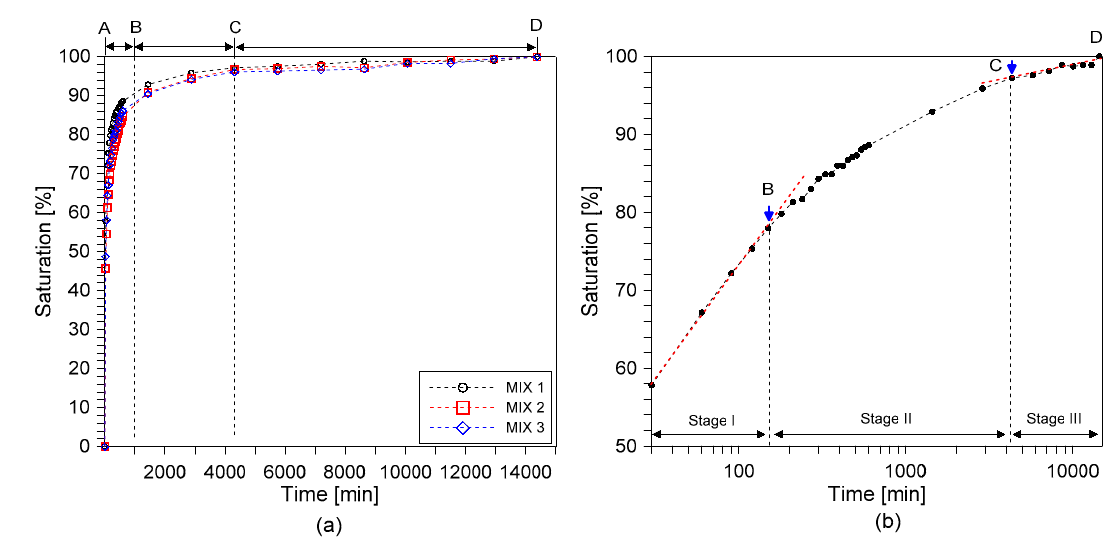
Figure 2. The curve of water saturation with stages in water saturation trend: ( a ) variation of saturation of the three concrete types (MIX 1, 2, and 3) in a linear time scale and ( b ) variation of saturation of concrete MIX 1 in a logarithmic time scale.